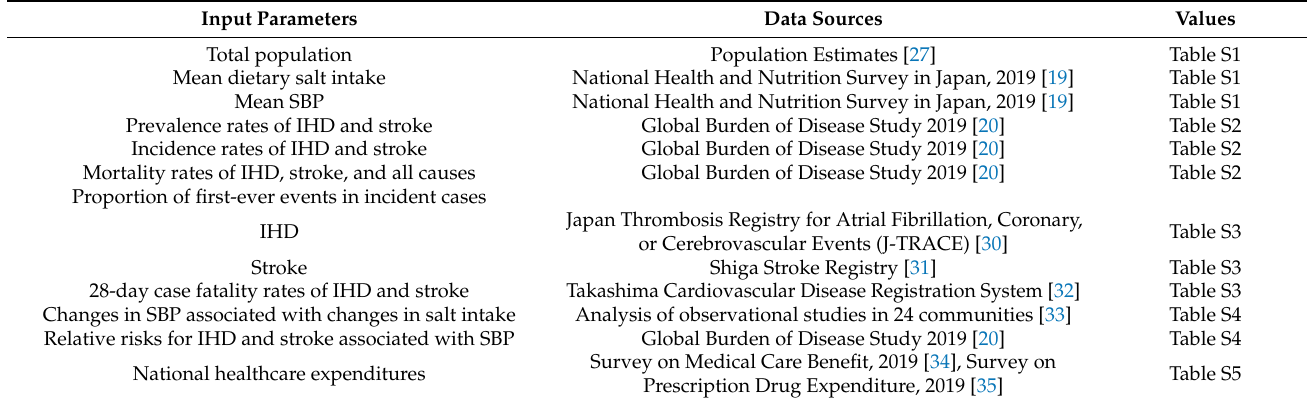
Table 1. Input parameters and data sources used in the Markov